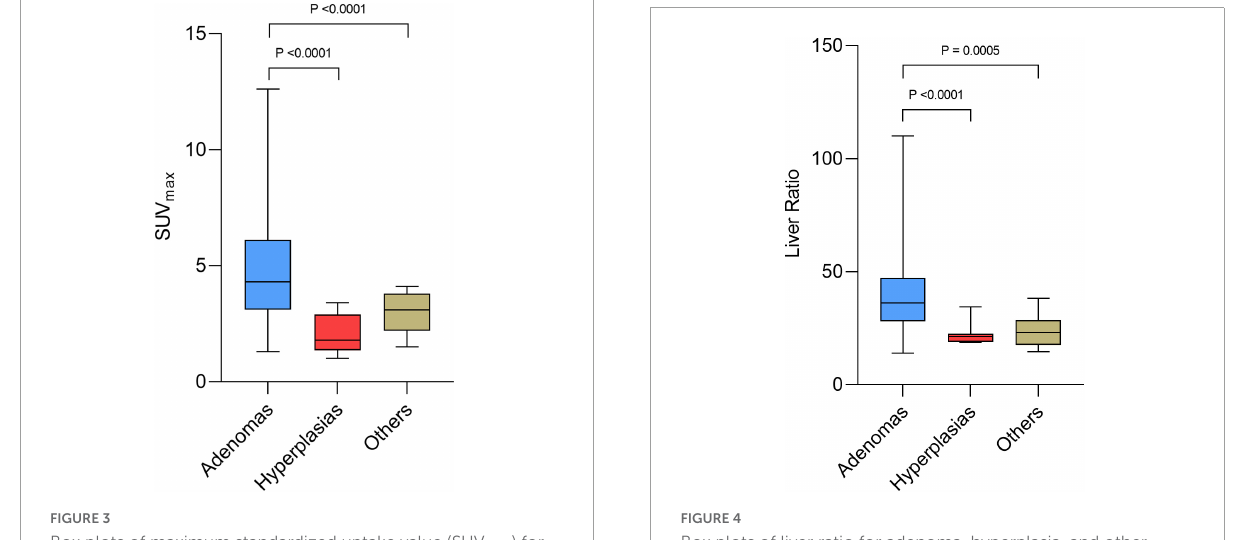
FIGURE4 Box plots of liver ratio for adenoma, hyperplasia, and other